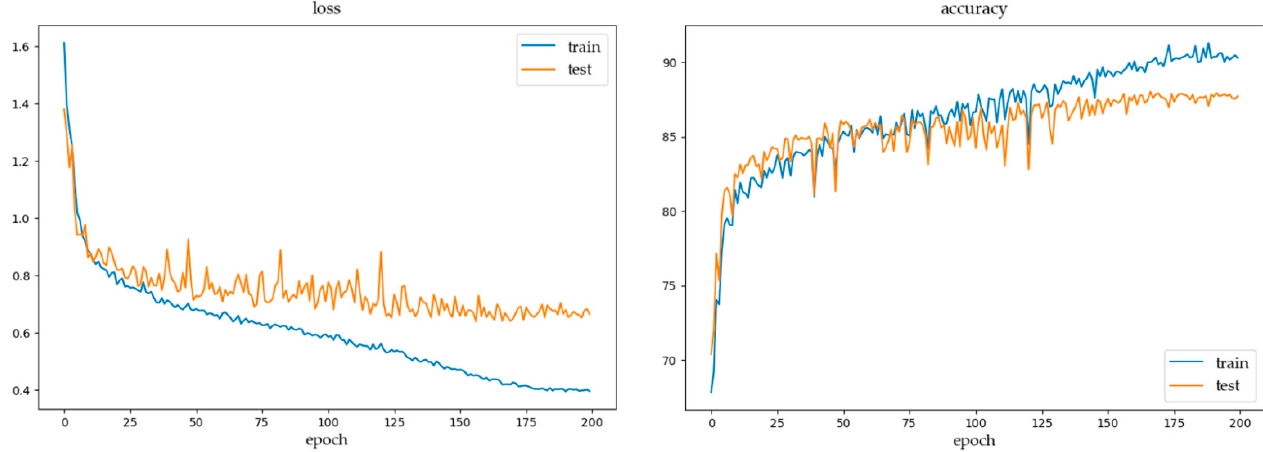
Figure 7. Line chart of loss and accuracy during